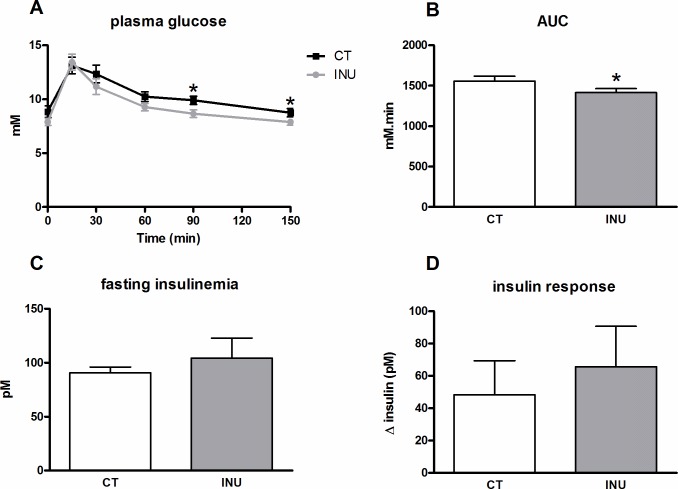
Effect of long term administration of inulin extract on postprandial blood glucose and serum insulin levels in sucrose-loaded mice.Mice were fed a control diet (CT) or a diet supplemented with 5% inulin (INU) for 3 weeks. Plasma glucose excursion after the oral sucrose load (A), area under the curve (AUC) of the glucose excursion (B), fasting insulinemia (C) and insulin response (Δ insulin concentrations 30 min before and 15 min after the sucrose load) (D). *p<0.05 (Student t test).